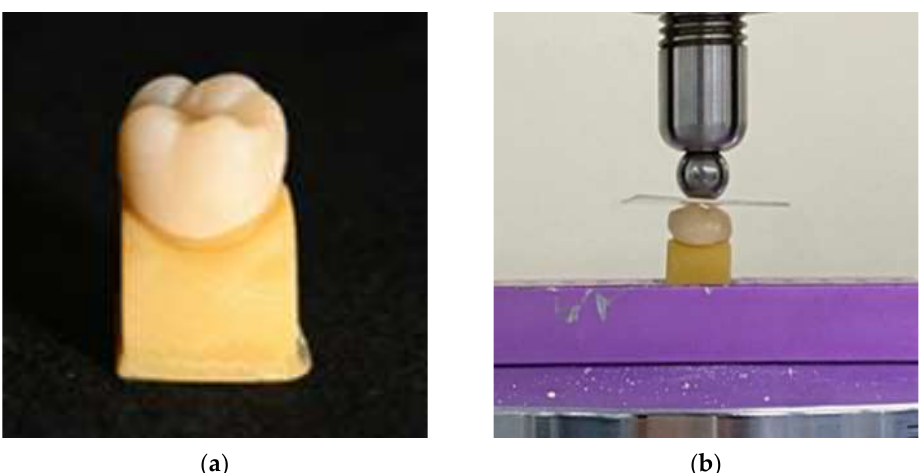
Figure 2. ( a ) CAD/CAM-fabricated zirconia crown and abutment die after cementation. ( b ) Load- to-failure test using a universal testing machine (Instron 3366, Instron Corporation, Norwood, MA, USA) with a crosshead speed of 1.0 mm/min and a 0.64 mm-thick polyethylene sheet (GS025, 3A MEDES, Gyeonggi-do, Korea) placed between the indenter and the specimen. MEDES, Gyeonggi-do, Korea) placed between the indenter and the